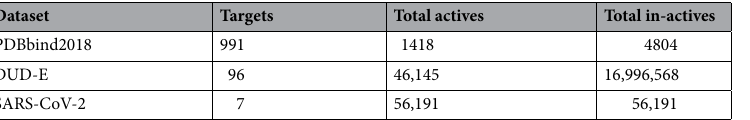
Table 2. Number of active complexes, inactive complexes, and protein targets in the PDBbind, DUD-E, IBS, and SARS-CoV-2 datasets used to create the training and test sets in this